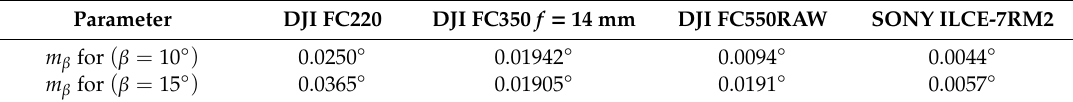
Table 4. Mean error of measurement m β calculated for β = 5 ◦ i β = 10 ◦ assumig that m f = 10 µ m (only the first component of the Formula (3) was used).